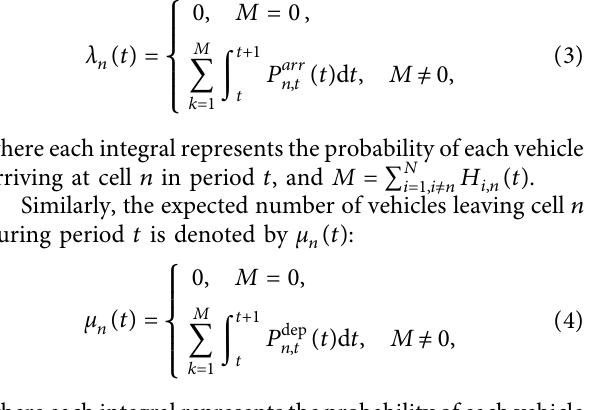
Figure 1: Model of the edge computation system in